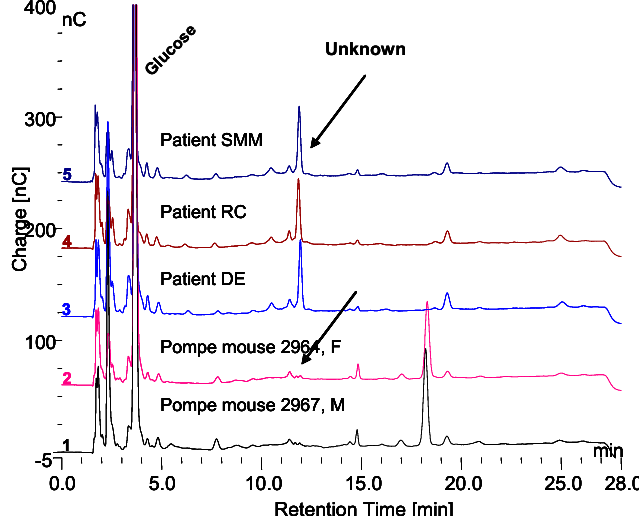
Figure 10. The 0.1 N HCl extracts of serum, 1:10 from two Pompe mice, age 8.7 months and three Pompe patients. The peak at about 18 min in the Pompe mouse serum is a glycosylated protein containing m -inositol, sorbitol and glucose as major components as well as galactose and mannose.